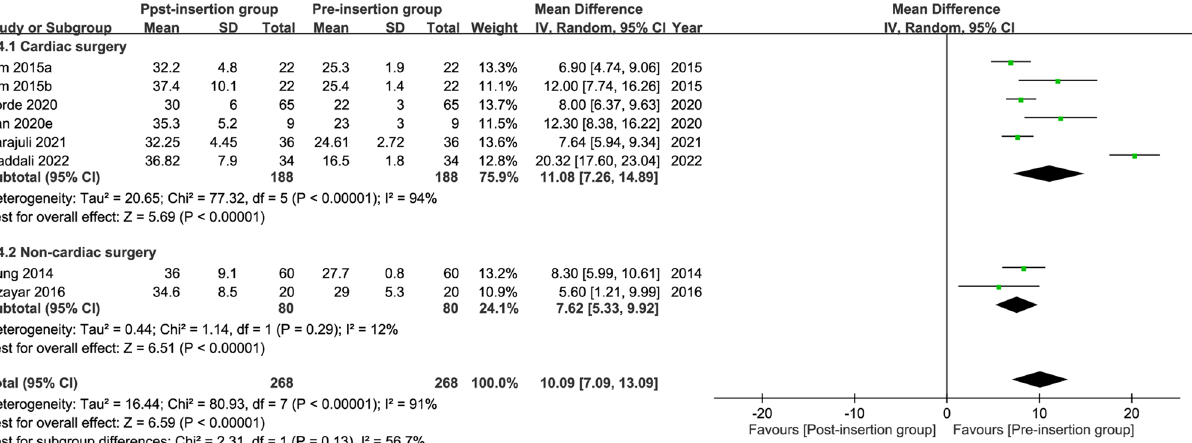
Figure 8. Forest plot for the comparison of changes in cuff pressure after esophageal medical device insertion in adults undergoing cardiac and non-cardiac surgery. CI confidence interval; M–H